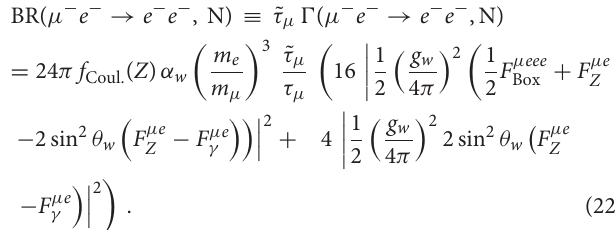
cLFV process Current